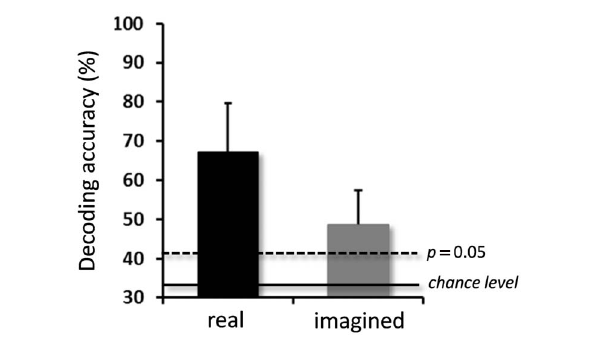
FIGURE 3 |Averaged decoding accuracies over participants for real and imagined movements. Significantly high decoding accuracies were obtained for both real and imagined movements (error bar = SD, N = 10). The two horizontal lines indicate decoding accuracy at chance level (33.3%, solid line), and at p = 0.05 (dashed line, binomial